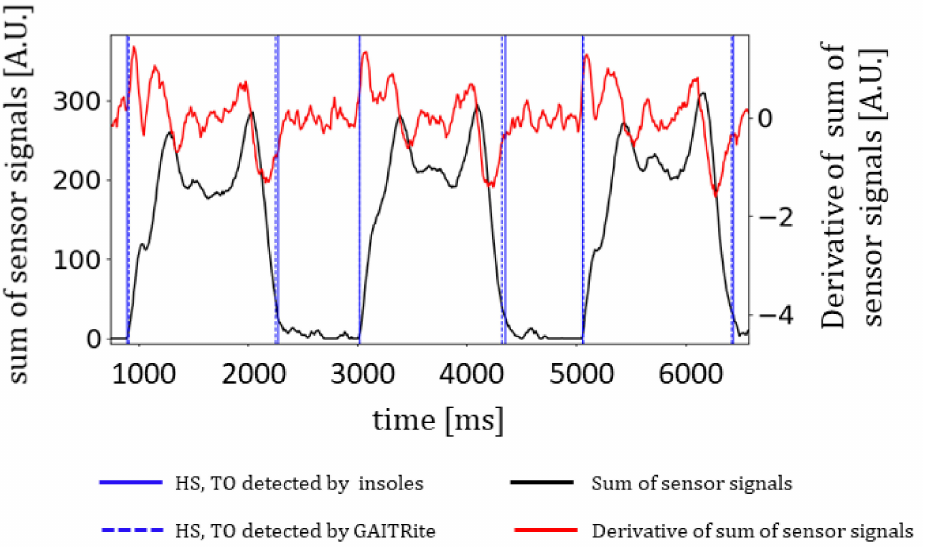
Figure 1. Detection of HS and TO events by the insoles and GAITRite ® . Stride length was calculated by integrating the acceleration two times and by removing drift values with a Kalman filter [17]. HS, TO and stride length were calculated in each insole and are defined as insole-based parameters. For each insole, these parameters were sent to a mobile phone by Bluetooth Low Energy (BLE). The velocity, stance, swing, step and single support durations and cadence defined as mobile-based parameters were calculated by a dedicated mobile application from the insole-based